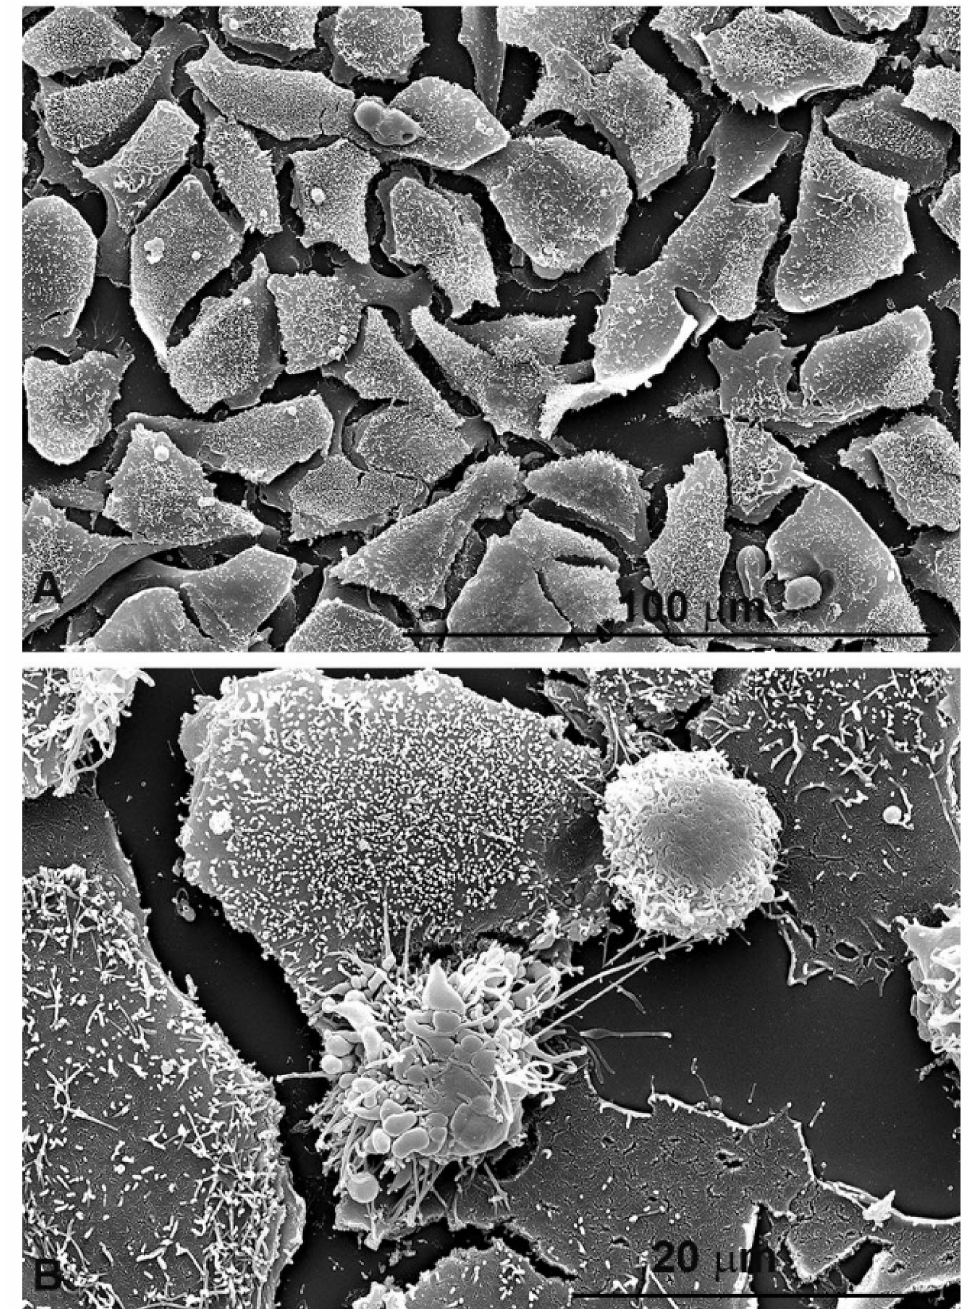
Figure 5. Scanning electron microscopic observations of morphological changes induced by Prunus sp. extract on HCT116 cells. ( A ) untreated HCT116 cells; ( B ) HCT116 cells treated with PsT 10 mg/mL plus NAC for 24 h. Cells were fixed with glutaraldehyde and sucrose in cacodylate buffer. After post-fixation with O s O 4 for 30 min, cells were dehydrated through graded ethanol concentration, critical point-dried in CO 2 (CPD 030 Balzers device, Bal-Tec, Balzers), and gold coated by sputtering (SCD040 Balzers device, Bal-Tec). The observations were performed with a field emission gun scanning electron microscope (Quanta 200 Inspect, FEI Company, Eindhoven, The Netherlands). For detailed description see Condello et al., 2015